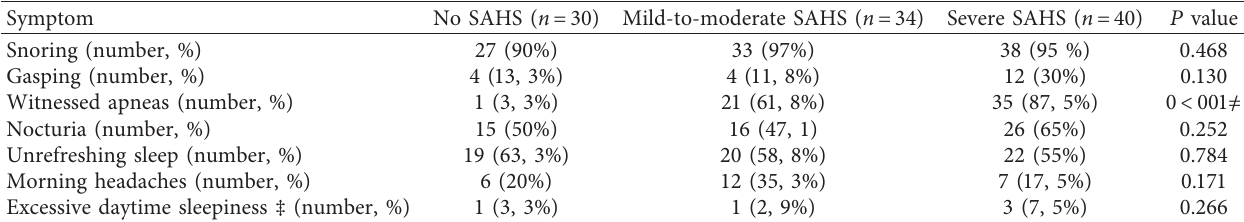
Table 2: Number and percentage of the subjects reporting each of the symptoms stratified by severity. Symptom